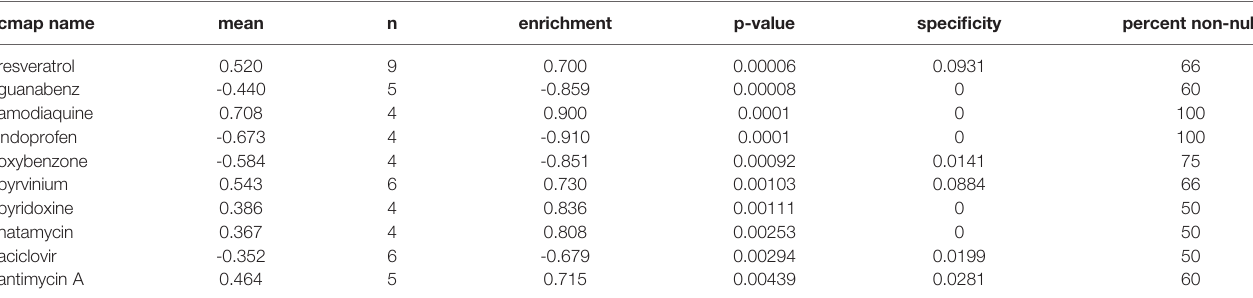
TABLE 1 | Results of CMap